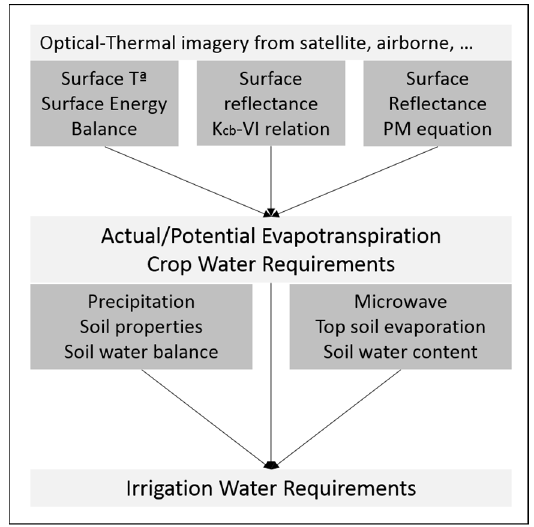
Figure 1. Overview of the remote sensing-based approaches for estimates of evapotranspiration and net irrigation water requirements. The spatial scale of these approaches is related to the pixel size of the utilized image data.